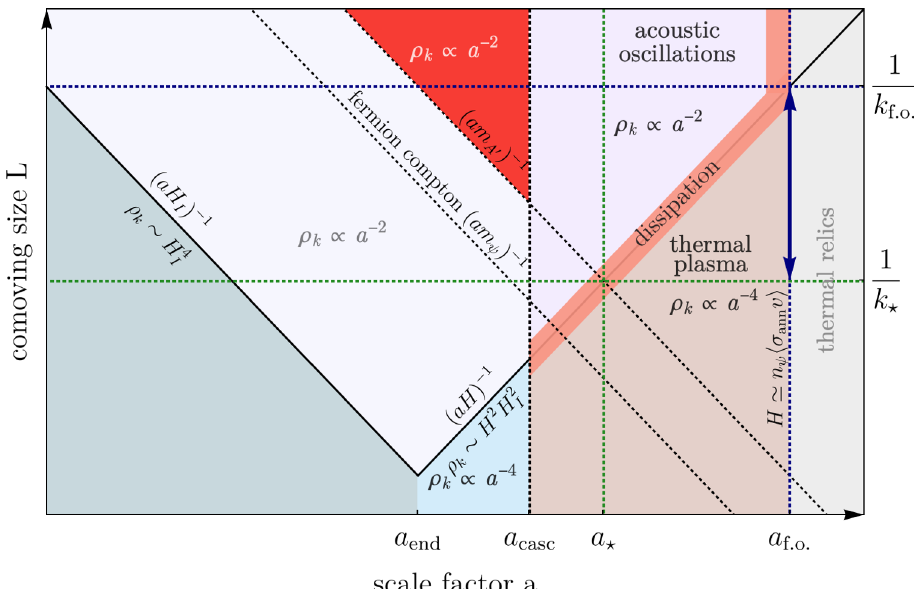
Figure 5. Adaptation of figure 2 for the case of massive dark QED ( m ψ (cid:29) m A 0 ): evolution of some key length scales (Hubble radius, Compton wavelengths of ψ and A 0 ) together with the scaling of the dark-sector energy density. The main differences are the following ones. At a casc a plasma of ψ and A 0 particles is present (see section E.2), generating a plasma frequency ω p & H that affects T the evolution of super-horizon A 0 modes, preventing them from oscillating at horizon entry (see L the discussion around eq. (C.10) and in appendix E.5). As these modes cross the horizon, their scattering off the plasma gradually dissipates their energy into the ψ − A 0 system, which for large T enough e d is in thermal equilibrium. In this scenario, the time a ? when H = m A 0 does not play a special role. When the ψ ’s freeze out at a f.o. , n ψ and hence ω p drop, leading to a fast redshifting of all super-horizon A 0 modes (see appendix E.6). The total DM energy density at a f.o. is of order L η 2 m 2 H 2 with a mildly different value of η relative to the case with no dark fermions (see eqs. (3.9) A 0 I and